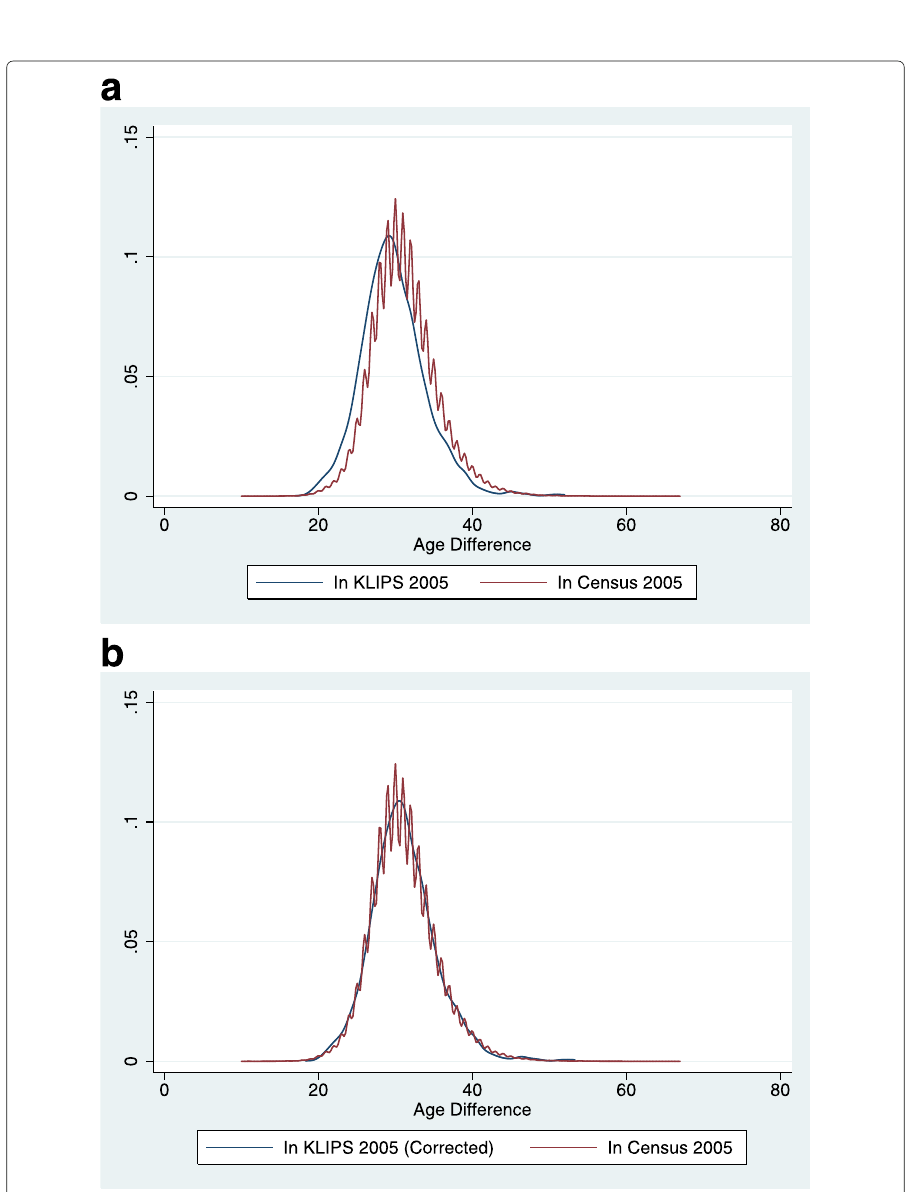
Fig. 1 Average age difference between fathers and sons in KLIPS 2005 and Census 2005. a Average age difference in the original samples. b Average age difference when the difference between KLIPS 2005